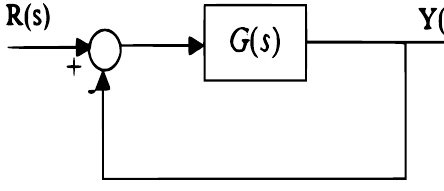
Figure 1. A feedback